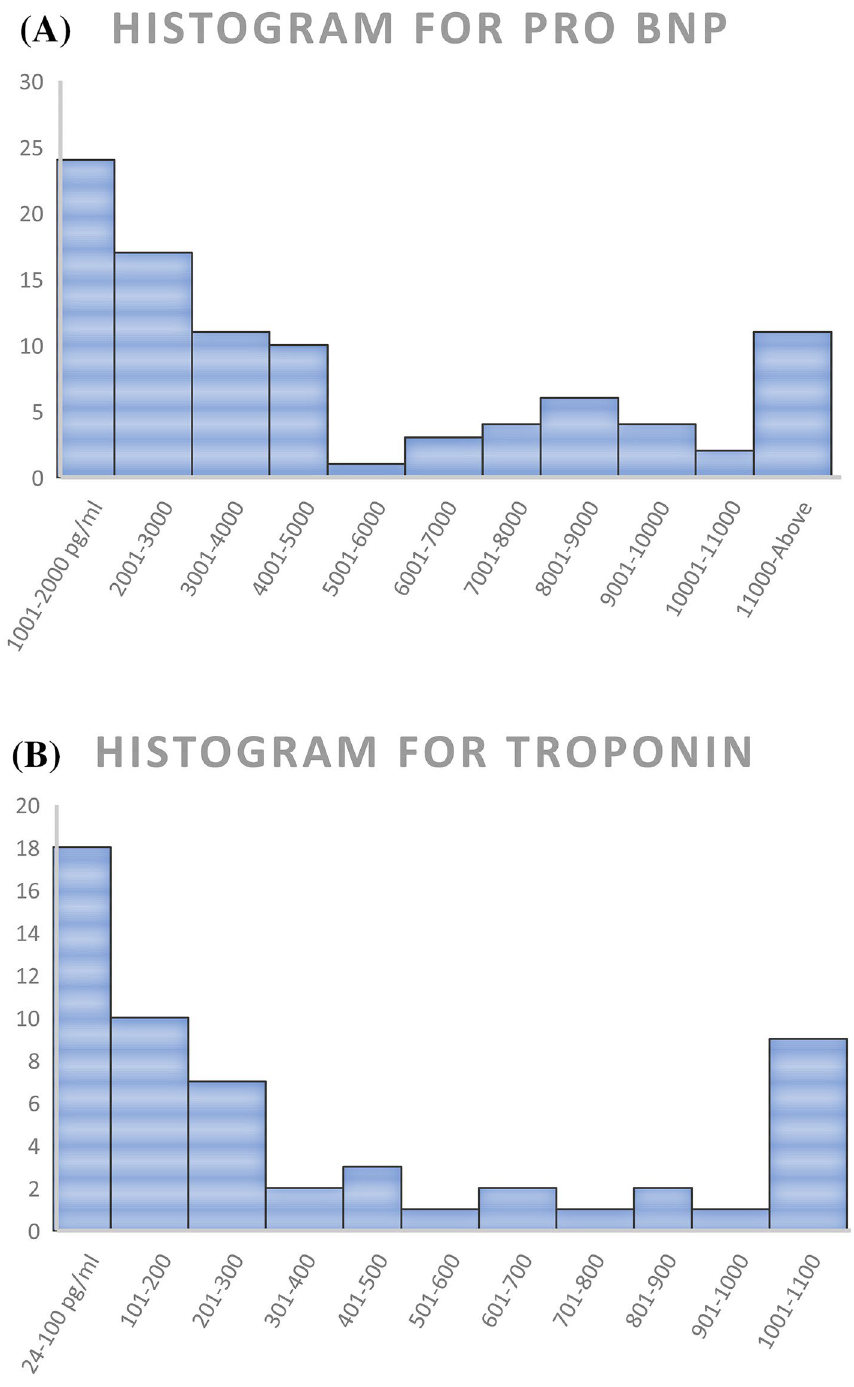
Figure 2. Baseline values of Pro-Bnp and high sensitivity troponin. ( A ) Baseline values of Pro Bnp. X axis represents Pro BNP range values, Y axis represents the number of subjects under each range. ( B ) Baseline values of Hs-CTnI. X axis represents Hs-cTn I range values, Y axis represents the number of subjects under each